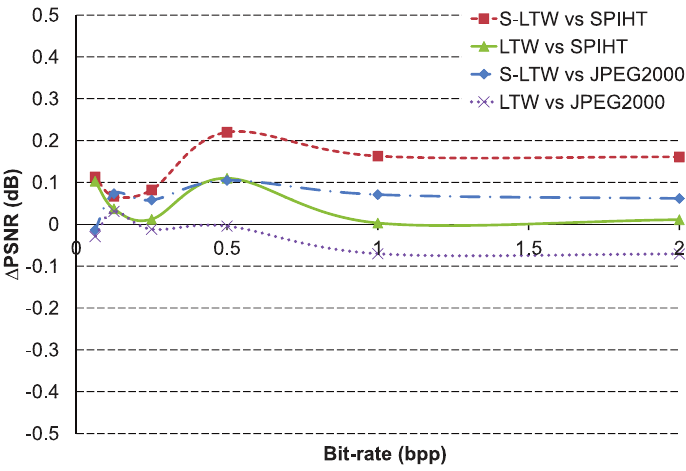
Figure 6. PSNR Gain for